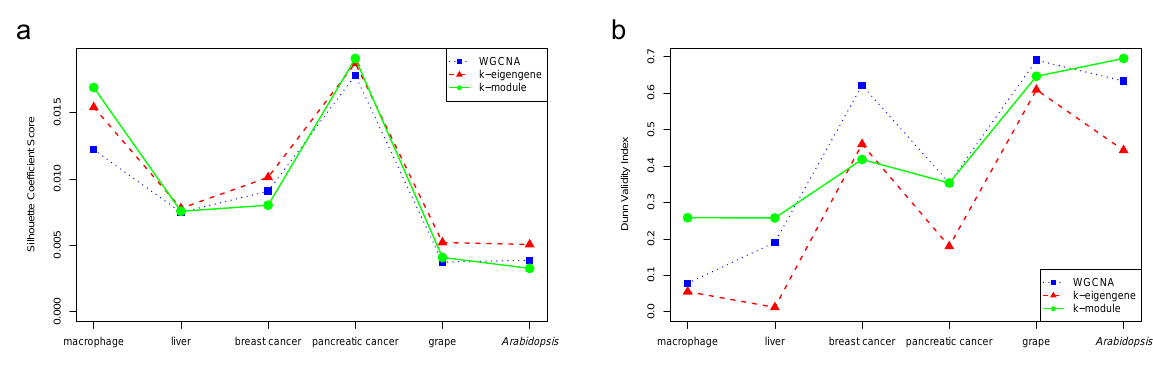
Figure 2. Silhouette coefficient score ( a ) and Dunn validity index ( b ) of WGCNA, k-eigengene, and k-module algorithms. The evaluation value obtained by the k-module algorithm was the highest in most of the datasets.